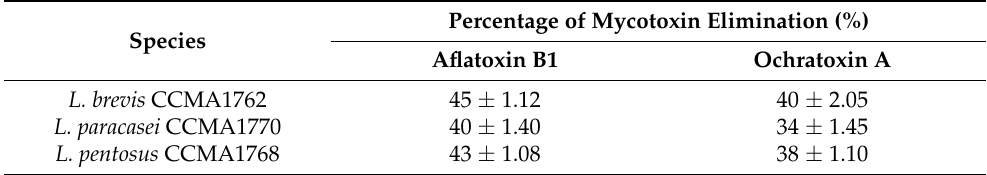
Table 6. Percentage of AFB1 and OTA eliminated by the LAB culture during adsorption